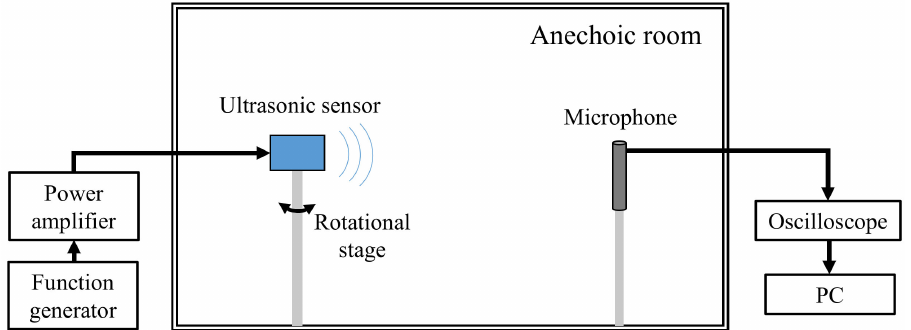
Figure 13. Schematic of the experimental setup to measure the beam pattern of the ultrasonic